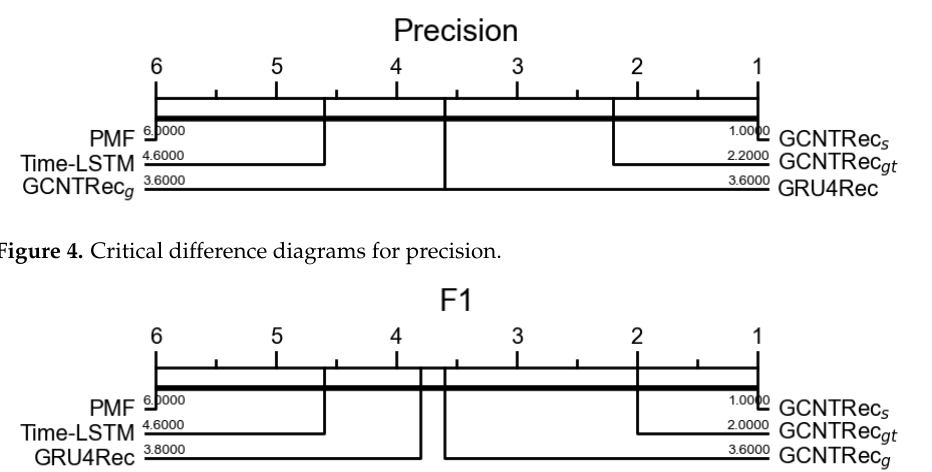
Figure 5. Critical difference diagrams for F 1 .